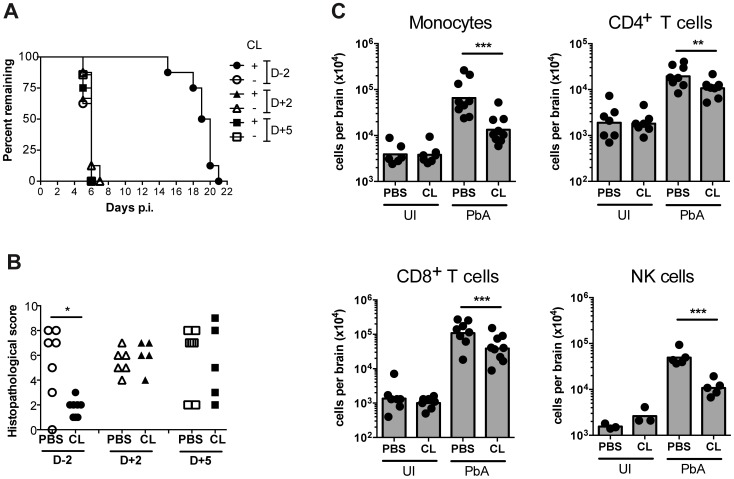
Effect of monocyte depletion on the development of ECM.(A) Mice were infected with PbA and administered with CL or sham-treated (PBS) i.v., at the indicated times. Survival time to a predetermined clinical endpoint is shown. (B) Histopathological scores of brain sections from mice in panel A. *p<0.05 (Mann-Whitney test vs. PBS control). (C) Effect of CL treatment on brain leukocyte populations. Uninfected (UI) or infected (PbA) mice were treated with CL or PBS on day +5 p.i., sacrificed on developing ECM (day 6), and the indicated BSL populations were quantified by flow cytometry. Symbols represent individual animals and bars the geometric mean. **P<0.01, ***p<0.001 (ANOVA on log-transformed data with Tukey's post-test). Data are pooled from two independent experiments (A, C) or a single experiment (B). NK cell data are from a single experiment.